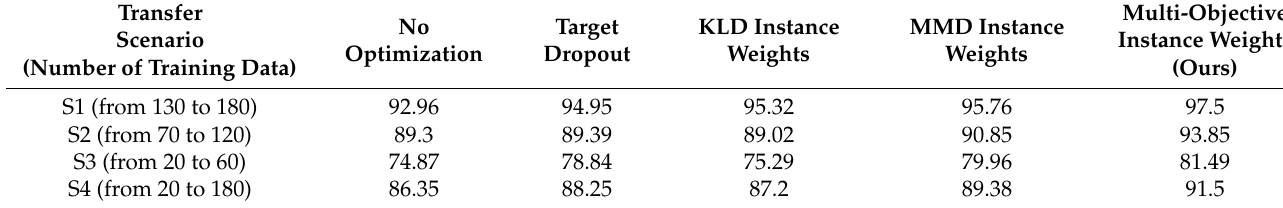
Table 6. Average accuracy according to the transfer scenario.